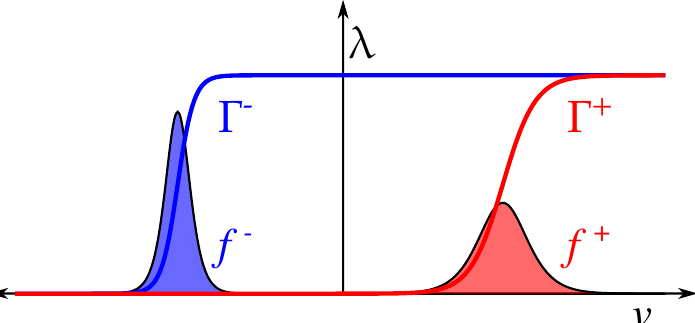
Figure 1. Threshold distributions f ± are bell-shaped. The number of active channels λ is a function of the applied potential v and evolves within the region delimited by Γ + and Γ −